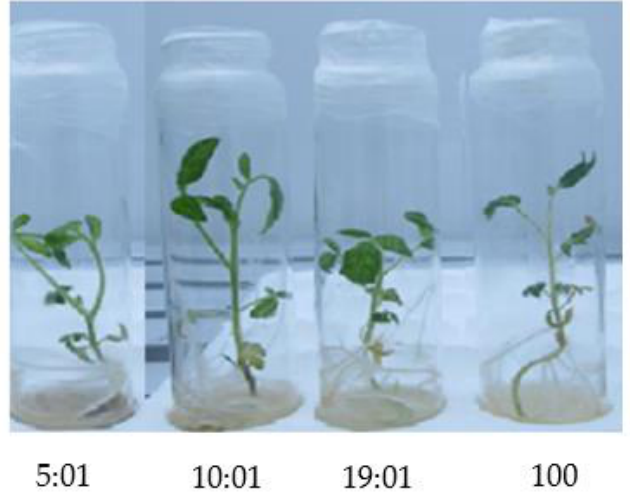
Figure 1. Tomato plantlets grown under different ratios of red (R) to blue (B) LED light. Photograph showing six weeks cultured plantlets.